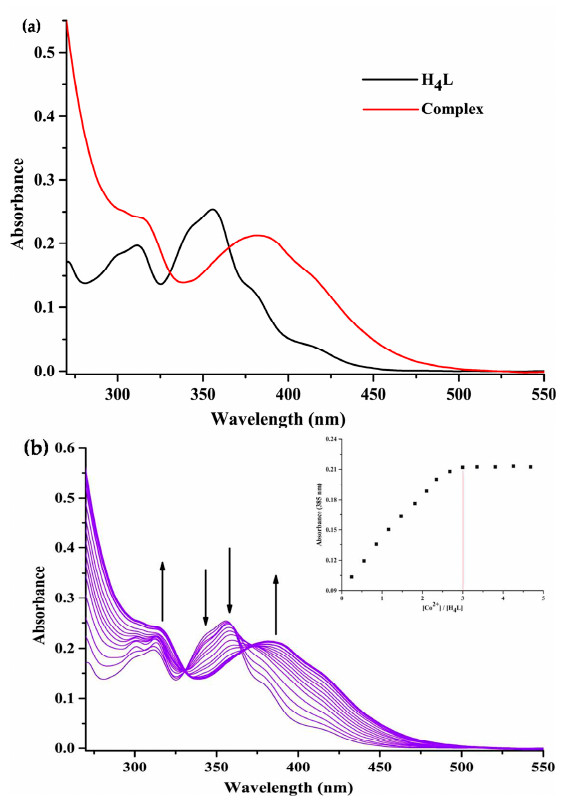
Figure 2. ( a ) UV-vis spectra of H 4 L and corresponding Co(II) complex; ( b ) Absorption spectra of the Co(II) complex in the presence of different concentrations of Co(II) ion (0–3 equiv.) in (DMF/CH 3 OH = 1:1, v / v